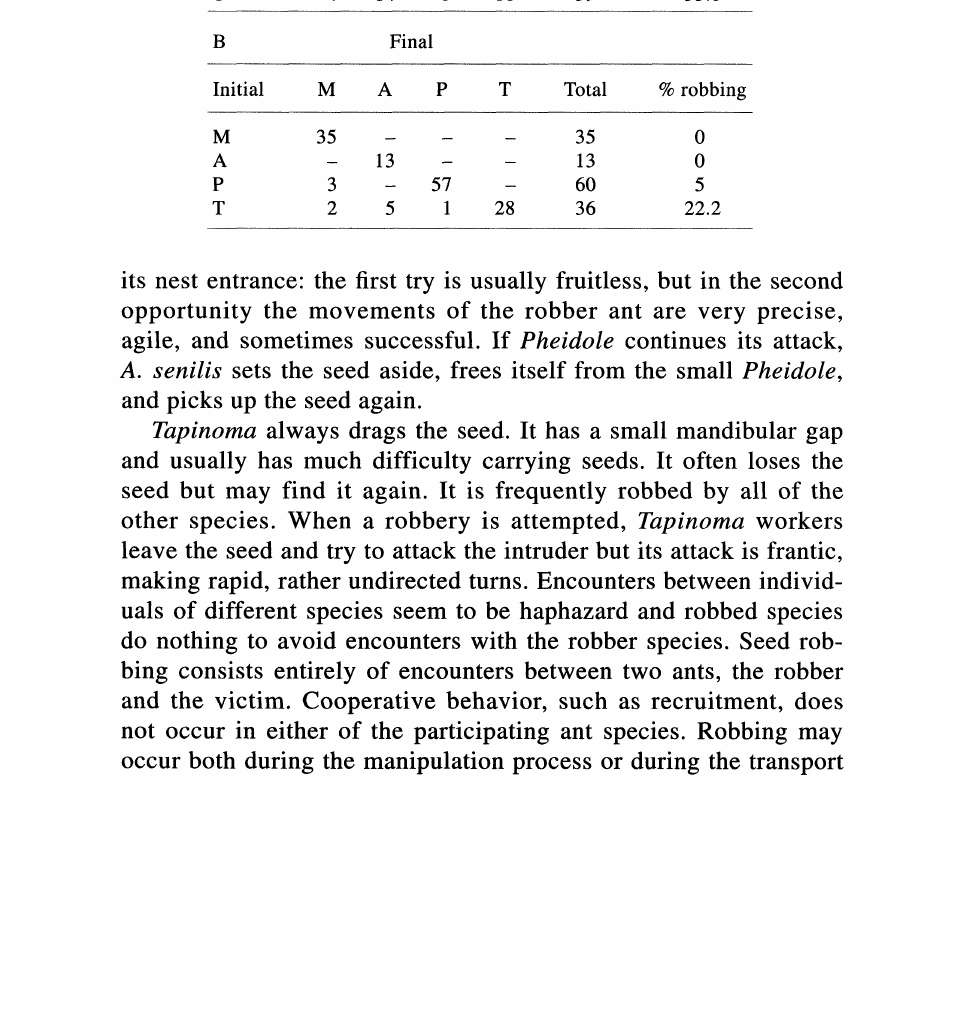
Table 1. Seed robbing in ants retrieving myrmecochorous seeds of Euphorbia characias at Collserola, NE Spain. Indi- cated is the species initially getting the seed and the species finally taking the seed to the next. A. July 1993. B. June